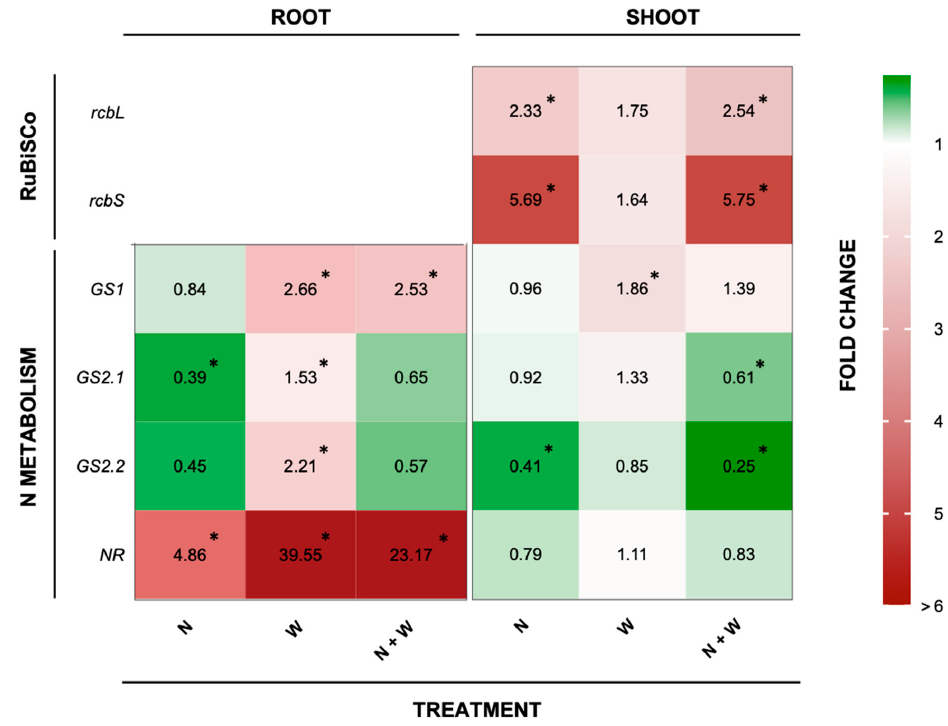
Figure 7. Relative fold of expression of RuBisCO and N metabolism-related genes in tomato cv. Micro-Tom roots and shoots as affected by nitrogen deficit (N; 5.3 mM N + 100% W), water deficit (W; 10.5 mM N + 50% W), or combined nitrogen and water deficit (N+W; 5.3 mM N + 50% W). The 2 − ∆∆ Ct values against the control are shown. * above mean values indicate significant differences compared to the control according to the t-test ( p = 0.05). Green indicates downregulation and red upregulation compared to the control plants. White indicates that gene expression was maintained at levels identical to the